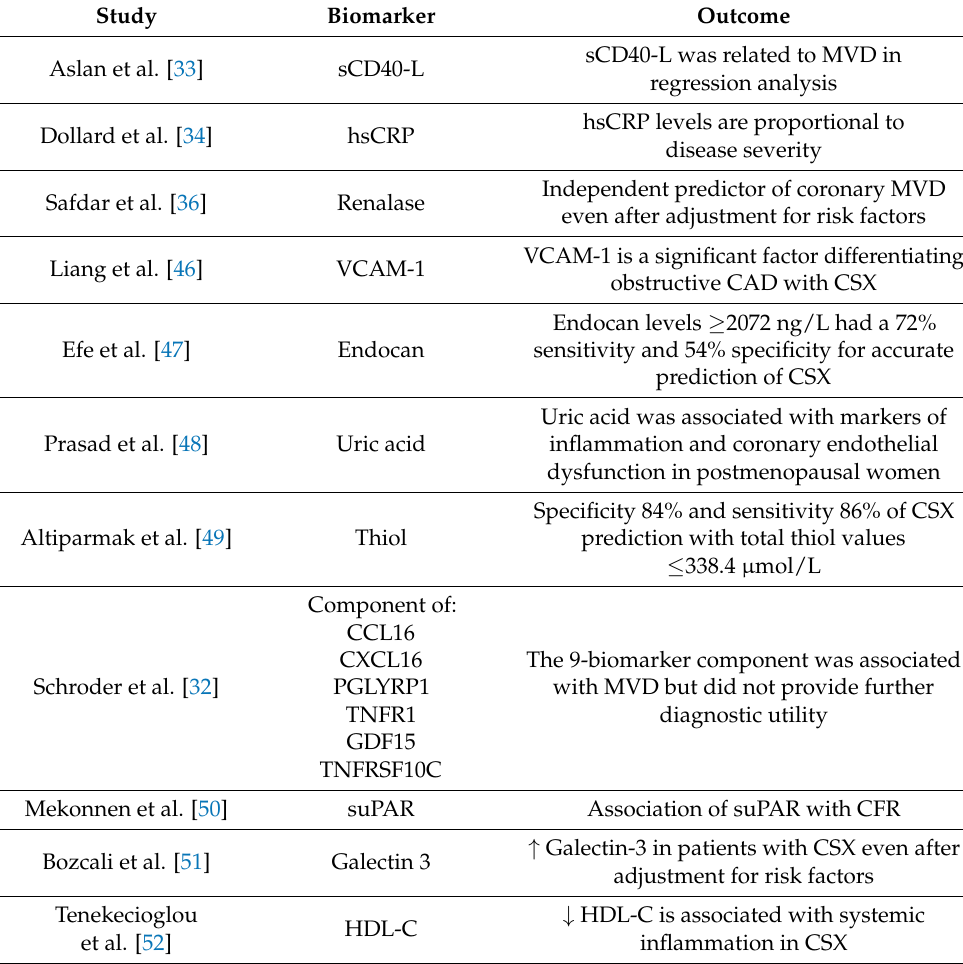
Table 1. Examined biomarkers in the field of coronary microvascular